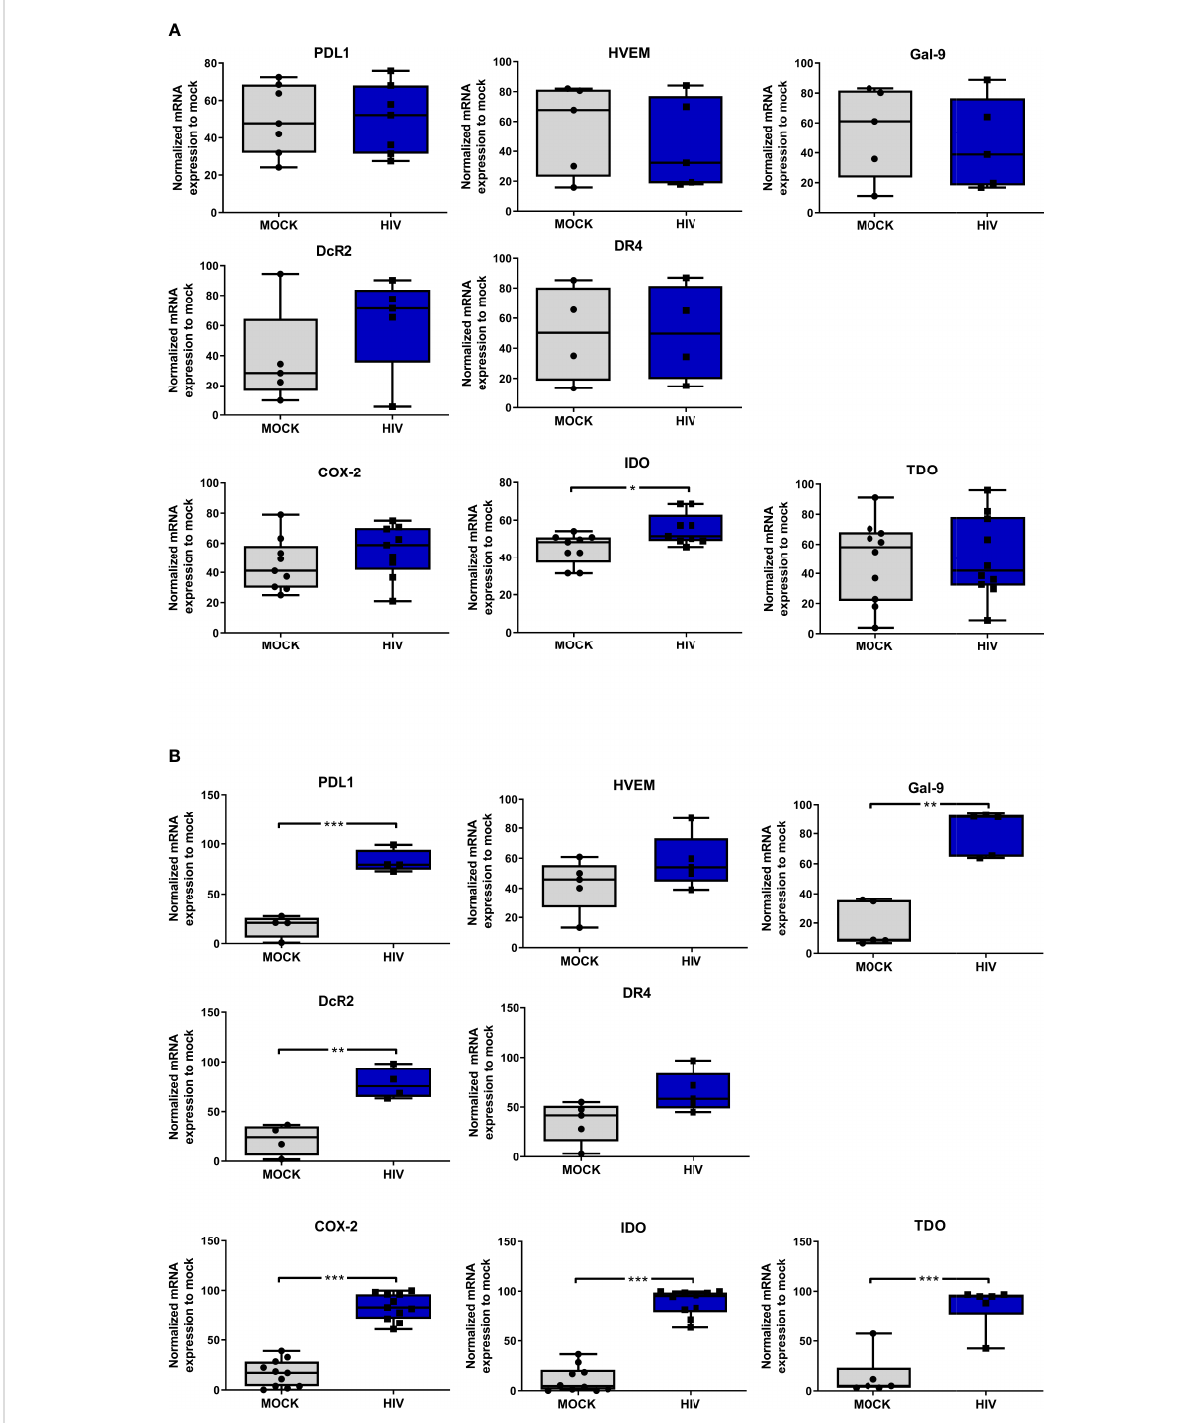
FIGURE 3 Presence of HIV in DC-T cells coculture give rise to DCs with an increased gene expression of factors associated with a tolerogenic phenotype. Mature DCs were pulsed with mock and HIV-1 BaL (HIV), and cultured 24h, washed and studied for gene expression levels of (A) PDL1, HVEM, Gal-9, DcR2, DR4, COX-2, IDO and TDO by DCs. N=7. DC-T cell cocultures, with or without HIV were harvested after 8 days. The gene expression levels in the day 8 coculture of (B) PDL1, HVEM, Gal-9, DcR2, DR4, COX-2, IDO, and TDO examined by PCR (N=5-11). The expression was normalized as ratios of 100%. Shown are min to max and all data points. * P <0.05, ** P <0.005, *** P <0.001, unpaired